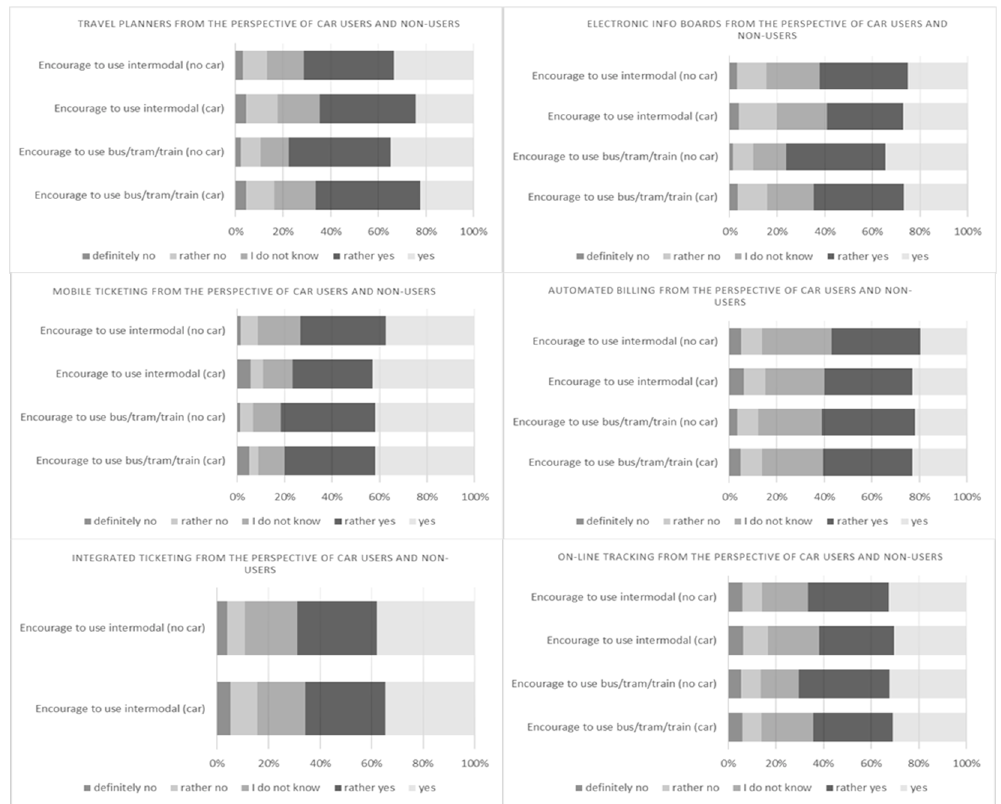
Figure 5. The di ff erence between the perception of ICT impact between private car users and non- Figure 5. The difference between the perception of ICT impact between private car users and users non- users (RQ6).